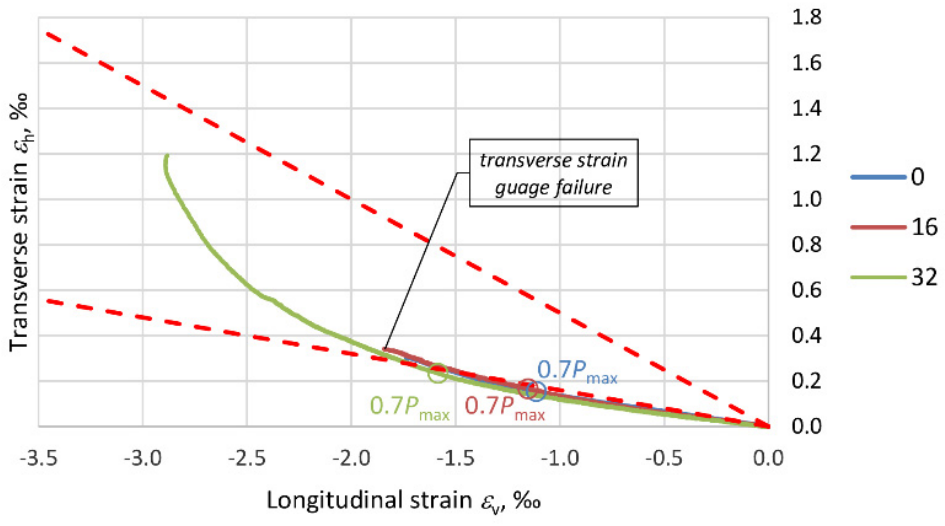
Figure 17. Graphs showing the variation of Poisson’s ratio ν for columns C_1V2H.